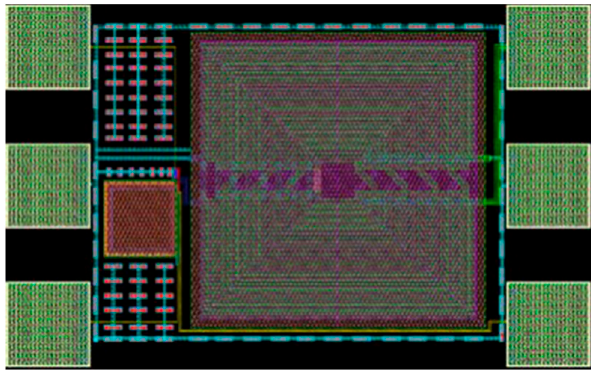
Figure 9. Layout of the MOSFET based RFED WuR with integrated transformer. Table 1. Summary of component values for the MOSFET-based envelope detector with transformer.